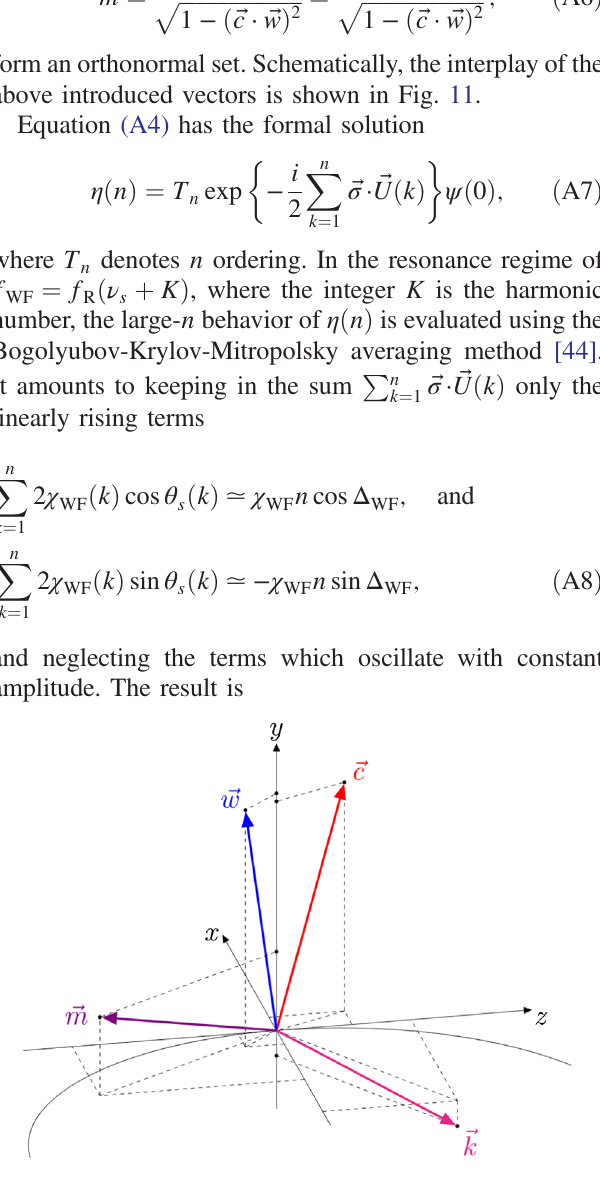
FIG. 11. Sketch of the relative alignment of the spin closed orbit vector ⃗ c , the rf field vector ⃗ w , upstream of the rf Wien